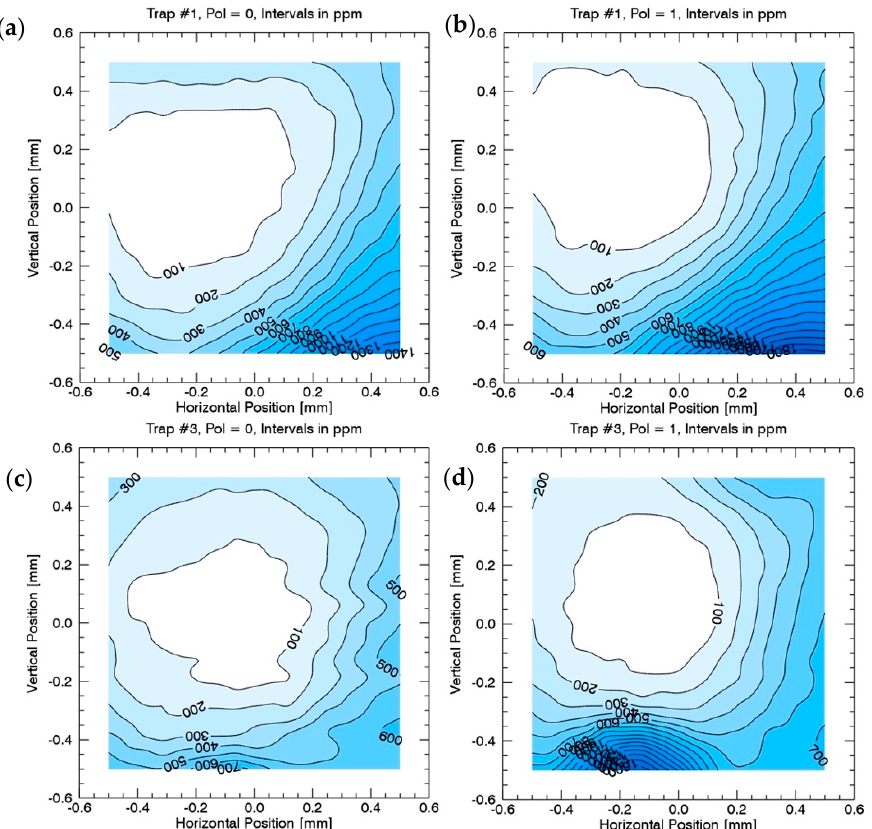
Figure 5. Panels (a) and (b) show the response uniformity maps for the Si trap #1 for both laser Figure 5. Panels ( a , b ) show the response uniformity maps for the Si trap #1 for both laser polarizations, polarizations, s and p, and (c) and (d) are the results for Si trap #3. Positional maps are shown with s and p, and ( c , d ) are the results for Si trap #3. Positional maps are shown with 100 ppm responsivity 100 ppm responsivity contours against the CR. Both the positional offset and angular acceptance contours against the CR. Both the positional o ff set and angular acceptance range were established to range were established to ensure a trap response uniformity to allow for a <200-ppm repeatability ensure a trap response uniformity to allow for a < 200-ppm repeatability transfer transfer measurement. Table 3. L-1 cryogenic radiometer standard Watt.